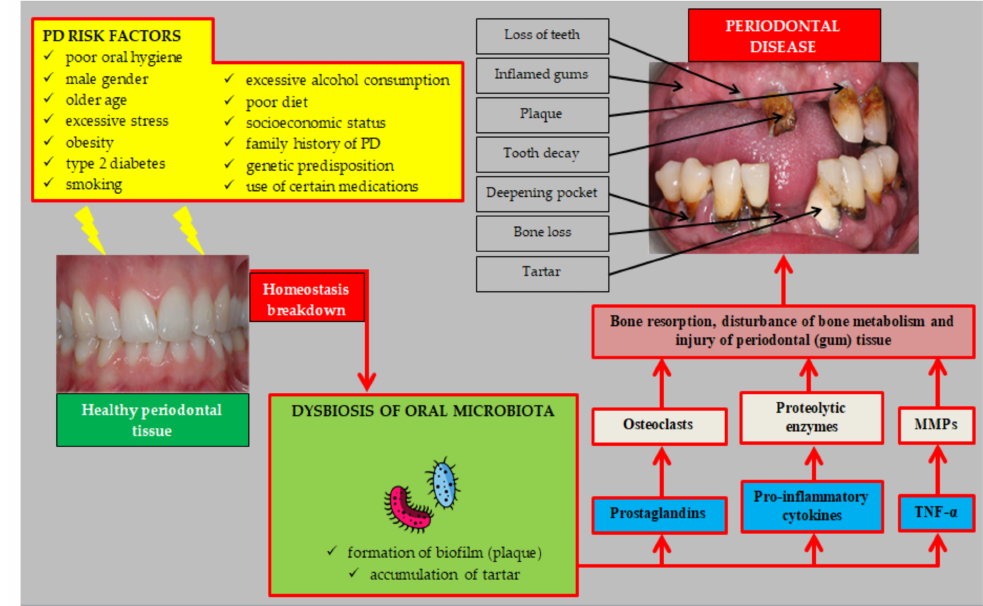
Figure 1. Etiopathogenesis of periodontal disease. Abbreviations: PD (periodontal disease); TNF- α (tumor necrosis factor α ); MMPs (matrix